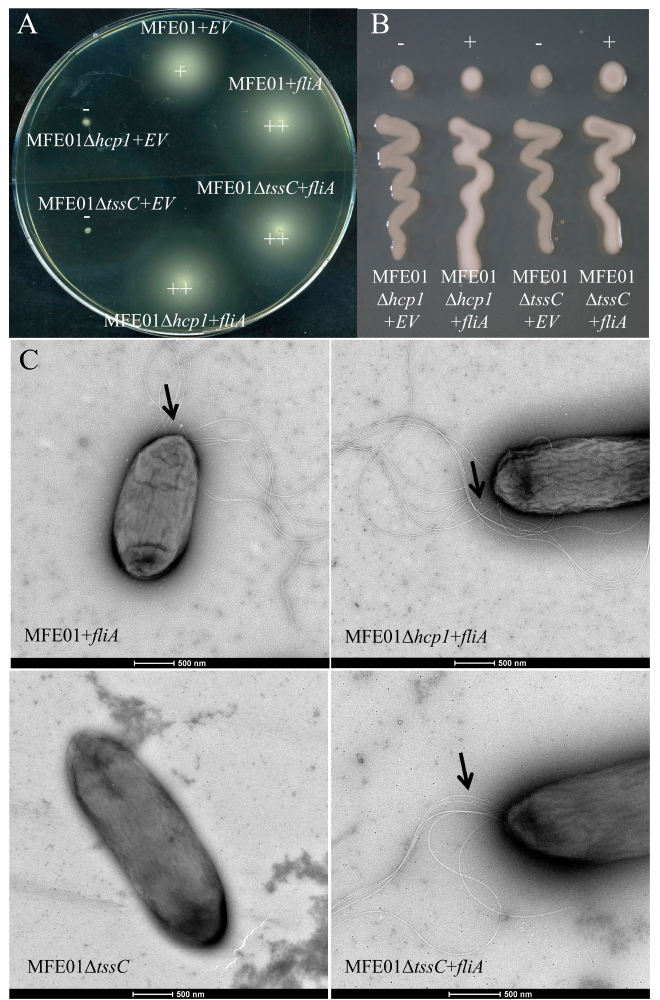
Figure 5. Effect of introducing fliA on phenotypes in MFE01 and derivatives. A . Impact of introducing fliA on the swimming motility of MFE01 and derivatives. Swimming assays were performed on 0.3% LB agar for 24 h at 28°C. +: motile, − : non-motile, ++: hyper-motile, EV: empty pPSV35 vector. The images shown are representative of three assays ( n = 3). B . Mucoid phenotypes after introducing fliA into MFE01 and derivatives. Mucoidy was assessed on 1.5% LB agar, supplemented with 50 µg/mL gentamycin, after incubation for 24 h at 28°C. EV: empty pPSV35 vector, +: mucoid, − : non-mucoid. The images shown are representative of three assays ( n = 3). C . Flagella of P. fluorescens MFE01 and derivatives after introducing fliA . Transmission electron microscopy images of bacteria grown at 28°C (negative stain). MFE01 Δ tssC contained the empty pPSV35 vector . Arrows indicate multiple flagella. These images are representative of at least 35 bacteria for each strain.